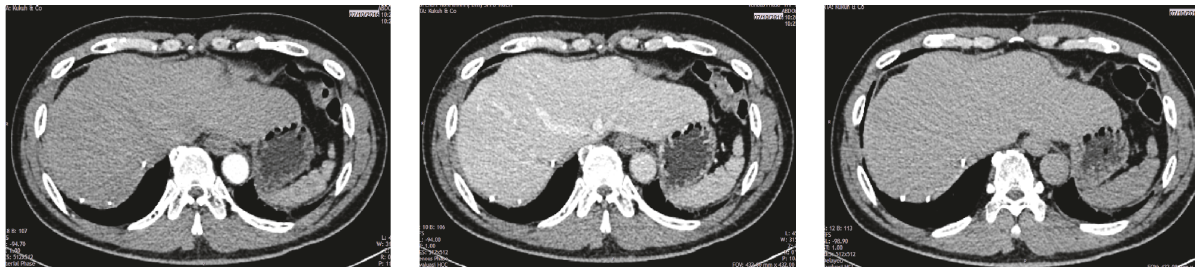
Figure 5: Arterial, venous, and delayed phase of Abdominal CT Scan 3 years after surgical resection (November